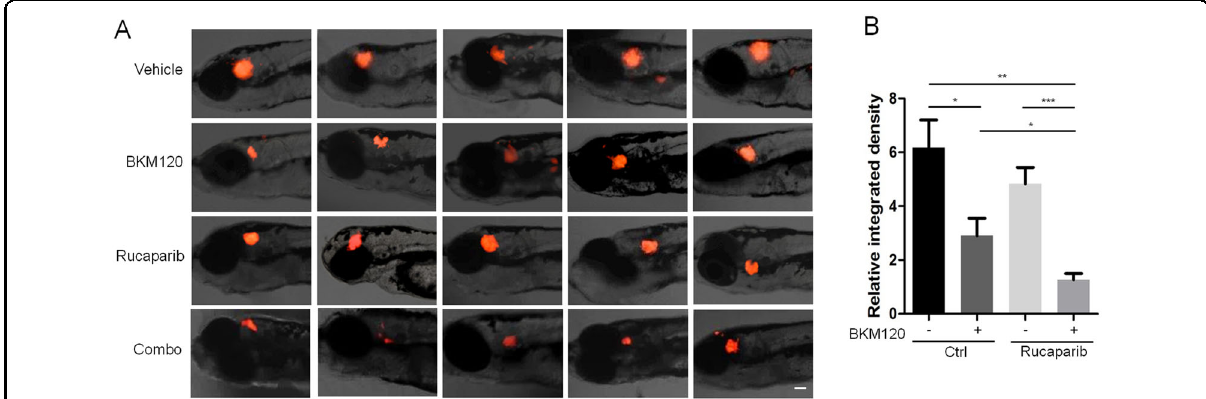
Fig. 4 BKM120/rucaparib combination treatment inhibits tumor growth in the U87MG zebra fi sh xenograft model. A After transplantation with 50 – 100 U87MG-RFP cells (red fl uorescence), the injected embryos were transferred to a 96-well plate containing drug and incubated for 96 h. The embryos were imaged with a fl uorescence microscope to detect tumor growth. Scale bar: 100 μ m. B The relative increase in fl uorescence intensity was determined by dividing the measured values by the fl uorescence intensity of the tumor in the same embryo at 0 days after implantation. Student ’ s t -test was used to compare the effect of each treatment with vehicle or treated animals. * P < 0.05; ** P < 0.01; *** P <